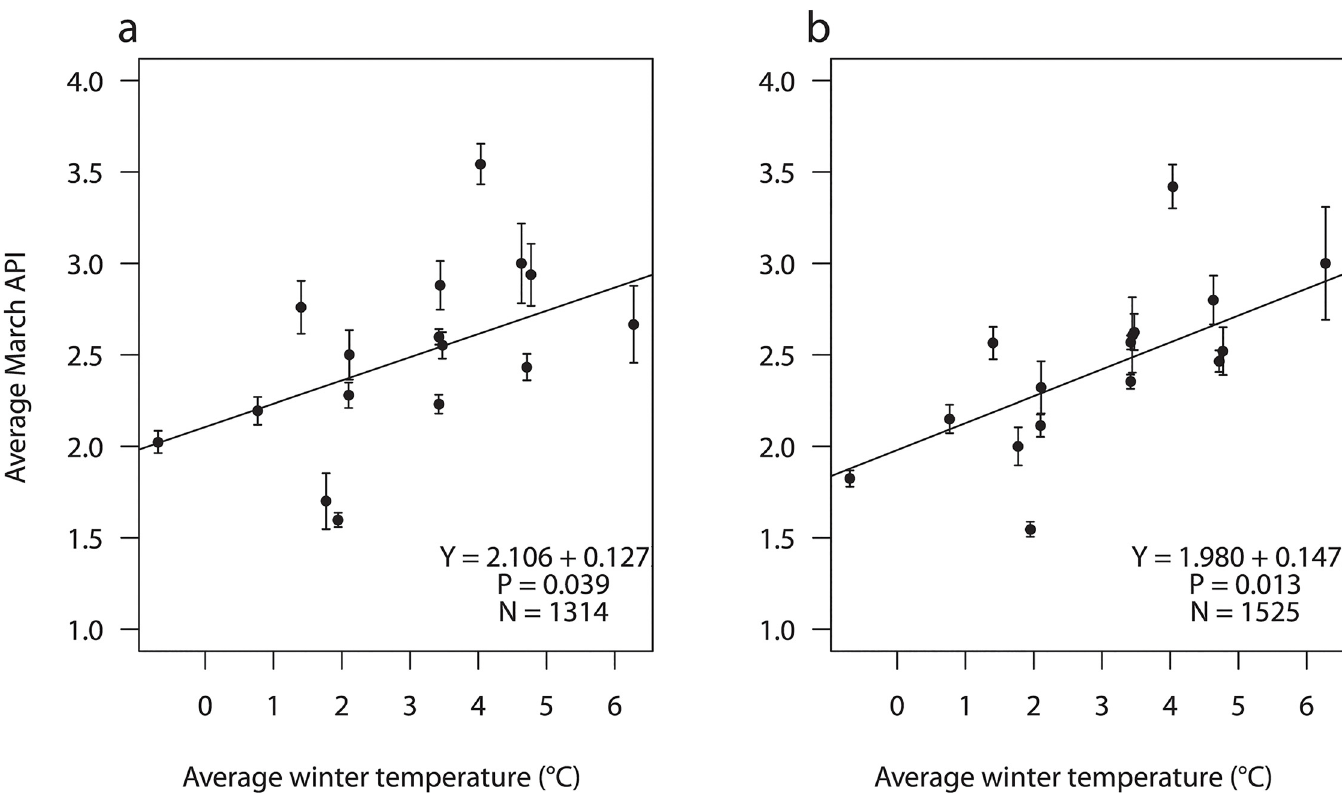
Fig 1. Relationship between average winter temperature and March body condition of pink-footed geese Anser brachyrhynchus . Average March body condition was assessed from the abdominal profile index (API) of (a) females and (b) males. Lines indicate least square fits from the linear mixed model (Table 1), and bars indicate standard errors. N indicates the number of geese included in the